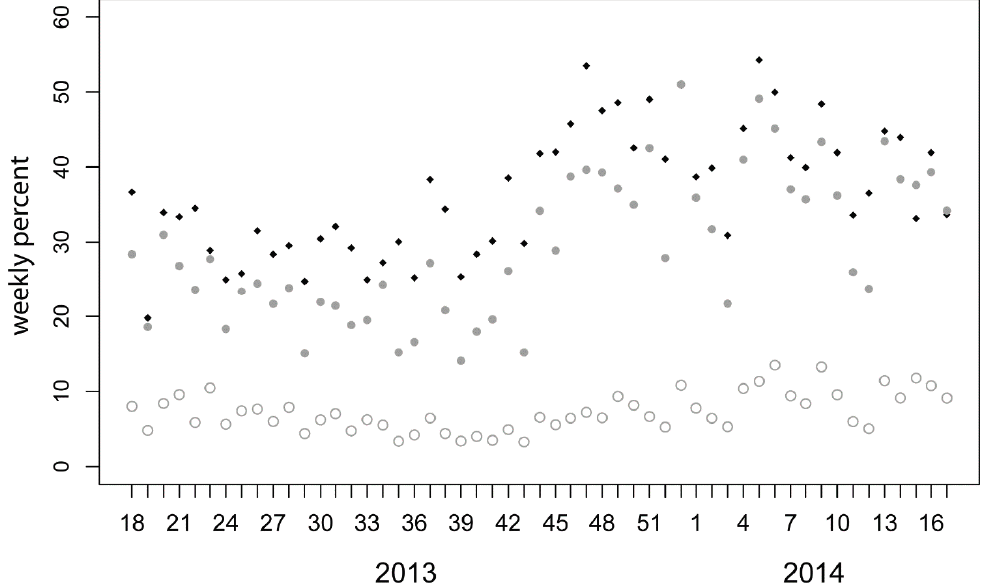
Figure 1. Weekly percentage of valid CONUS Landsat 8 pixels detected as high confidence cloud (black diamonds), high confidence cirrus (grey filled circles), high confidence cirrus that coincided with low confidence cloud (grey open circles), for 53 weeks spanning week 18 of 2013 to week 17 of